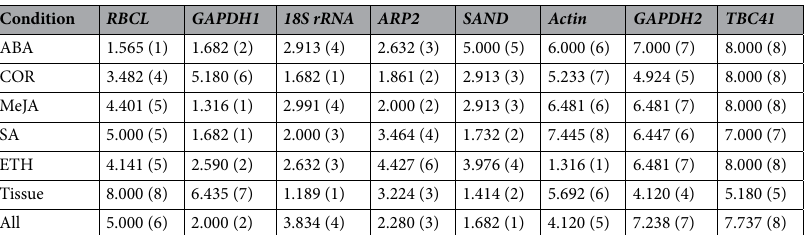
Condition RBCL GAPDH1 18S rRNA